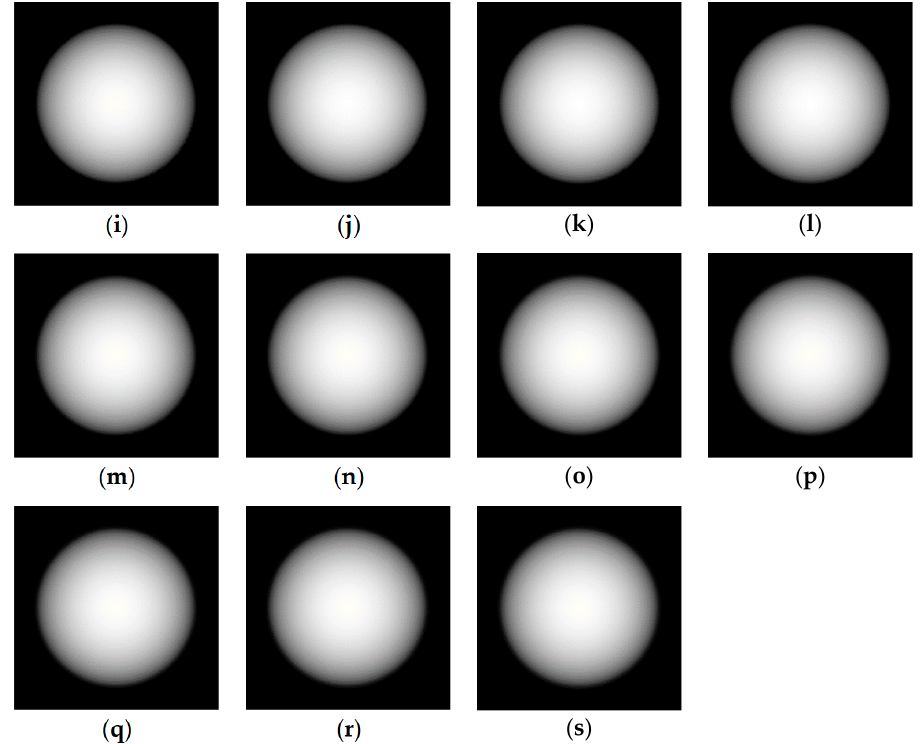
Figure A1. The decomposed background of Figure 1a by Fourier transform method with different parameter values. ( a – s ) are the decomposed background by Fourier transform method with 1th to 19th of filtering window sizes of [2:1:20], respectively.